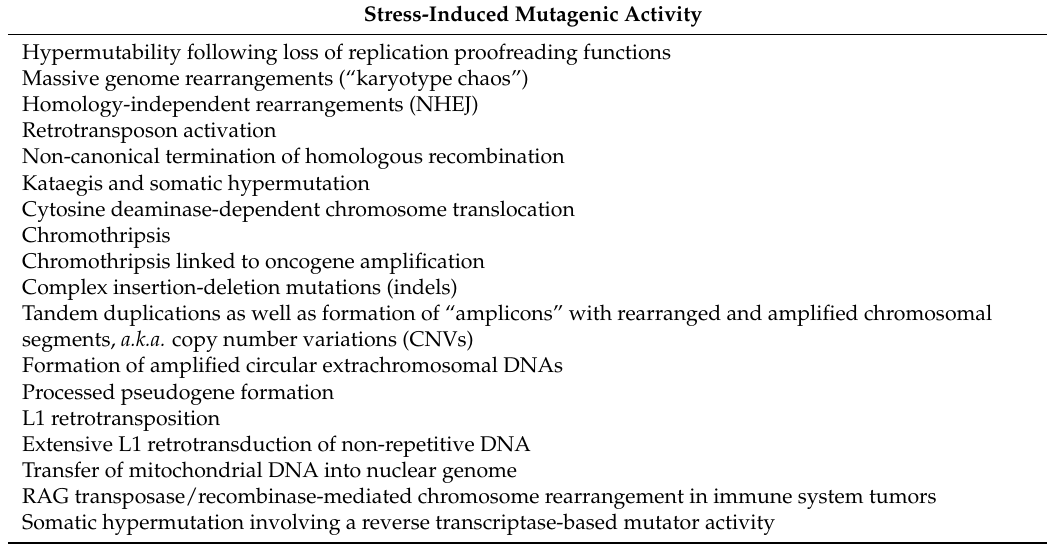
Table 17. Different Genome Changes Observed in Cancer